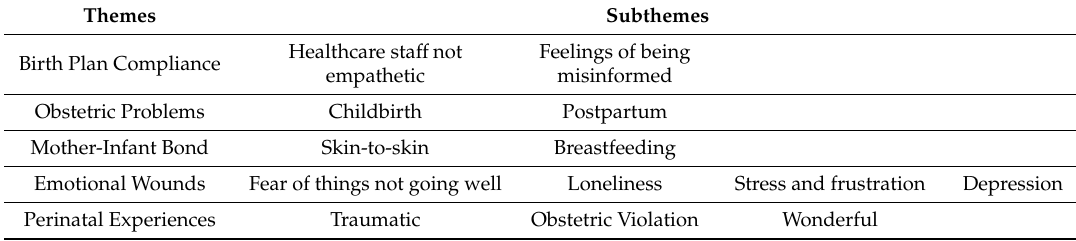
Table 1. Themes and